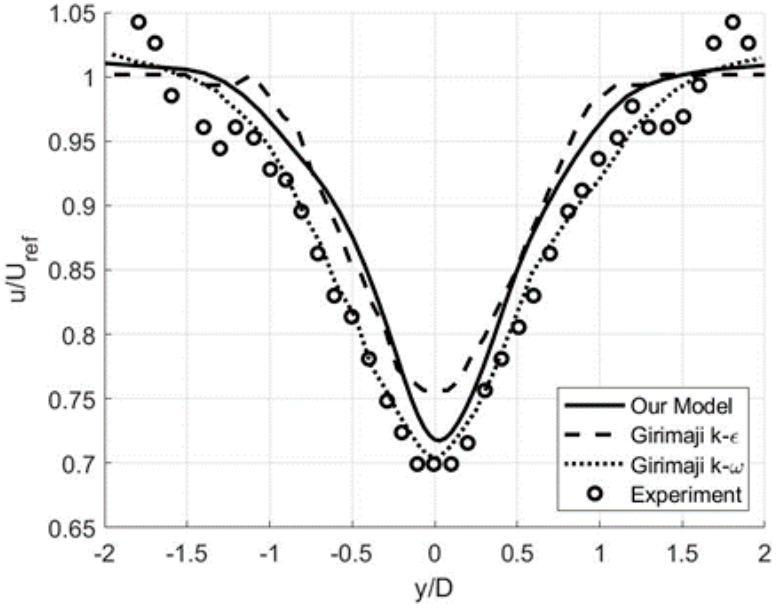
Figure 18. The mean streamwise velocity profile at x / D = 3 (𝑓 (cid:3084) = 1.0, 𝑓 (cid:3038) = 0.7) .